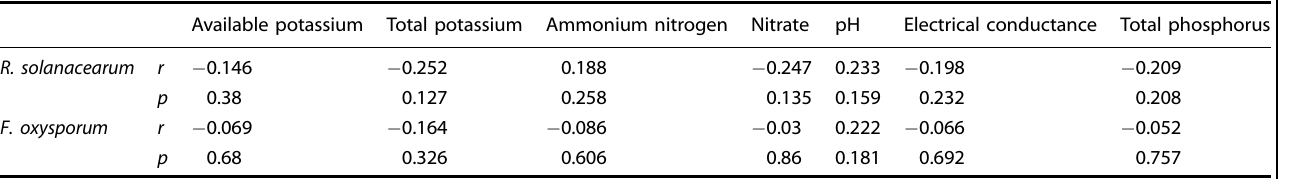
Fig. 2 Quantitative PCR results for R. solanacearum and F. oxysporum in the bulk soil and rhizosphere. a Abundance of R. solanacearum and F. oxysporum . b Correlation between two kinds of pathogens ’ abundant of different compartment. CKOF: organic fertilizer was amended in un-fumigated soil; CKBF: bio-organic fertilizer was amended in un-fumigated soil; FOF: organic fertilizer was amended in fumigated soil; FBF: bio-organic fertilizer was amended in fumigated soil. Different letters indicate signi fi cant differences among the four treatments as de fi ned by Tukey ’ s test ( p < 0.05). Table 1. Partial correlation test between soil properties and abundance of two kinds of